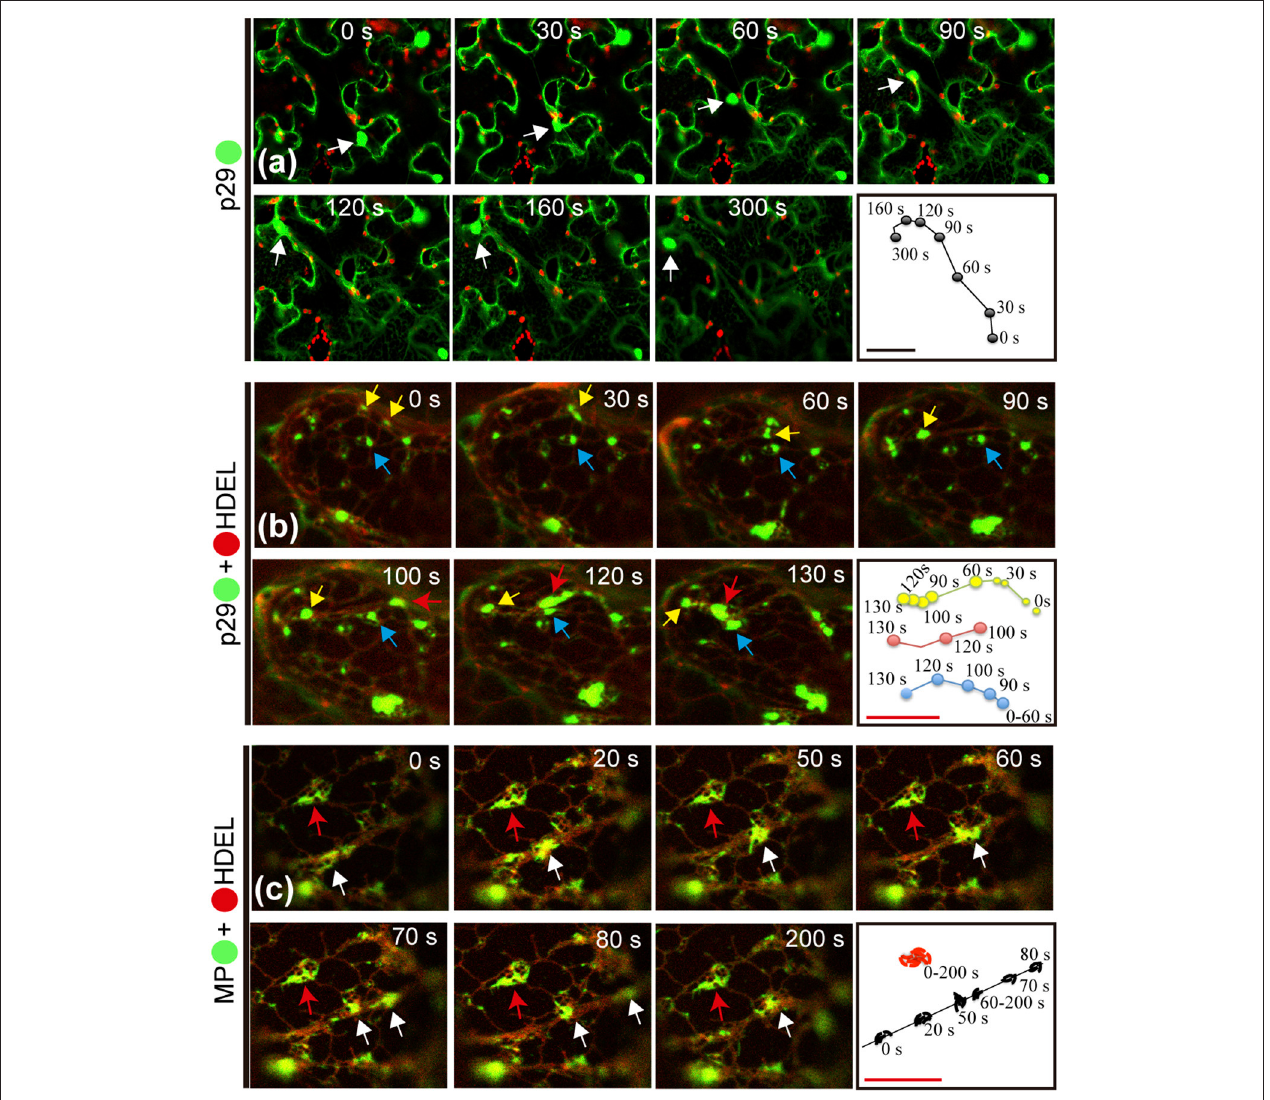
FIGURE 6 | Citrus leprosis virus C p29 punctate/inclusion bodies and MP filamentous aggregates traffic along the cortical ER. (a–d) Time-lapse images from individual expression of the p29:eGFP (•) and co-expression of p29-• and MP-• with mCherry(•)-HDEL (ER marker). An arrow marks the position of the p29 and MP structures at each time point. Right panels trace the way of the p29 and MP structures along the cortical ER. (a) Unidirectional movement of the p29 inclusion body along the cell cytoplasm. (b) Different punctate bodies highlighted by the yellow, blue, and red arrows traffic at different times along the cortical ER. The fusion between two granules is shown in times of 0–90s by the yellow arrow. (c) Go and stop movement (white and red arrows, respectively) of the MP filamentous aggregates is observed along the cortical ER. Fragmentation of the MP aggregates is visualized at time 70–80s. The frames were each obtained every 10s and a total of 50 frames. Red and black bars correspond to 10 and 50 µ m,